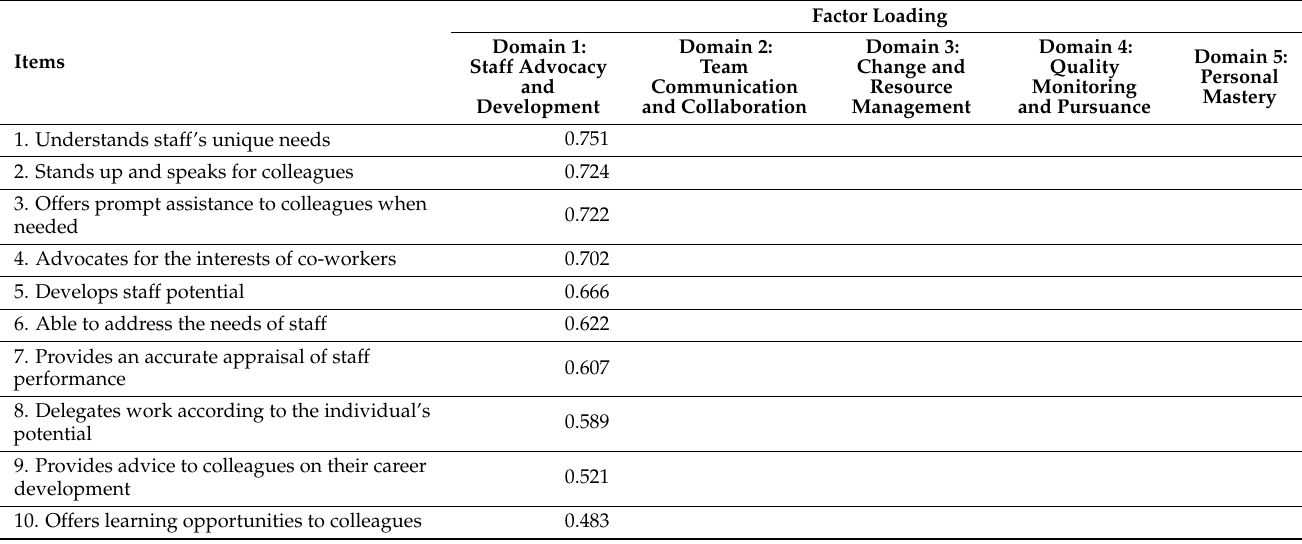
Table 1. Psychometric properties of the nurse manager competency